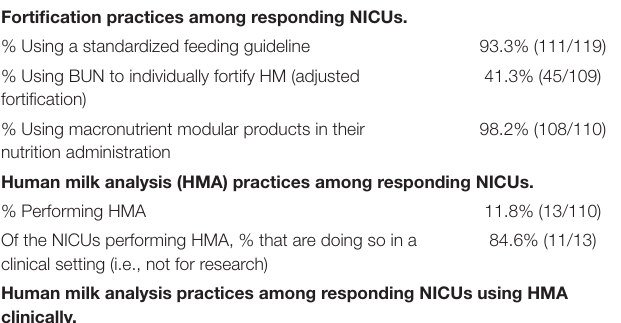
TABLE 3 | Human milk (HM) fortification and analysis practices. Fortification practices among responding